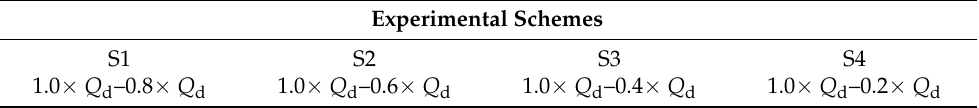
Table 3. The experimental scheme of rapid changing of flow rate for ballast pump.